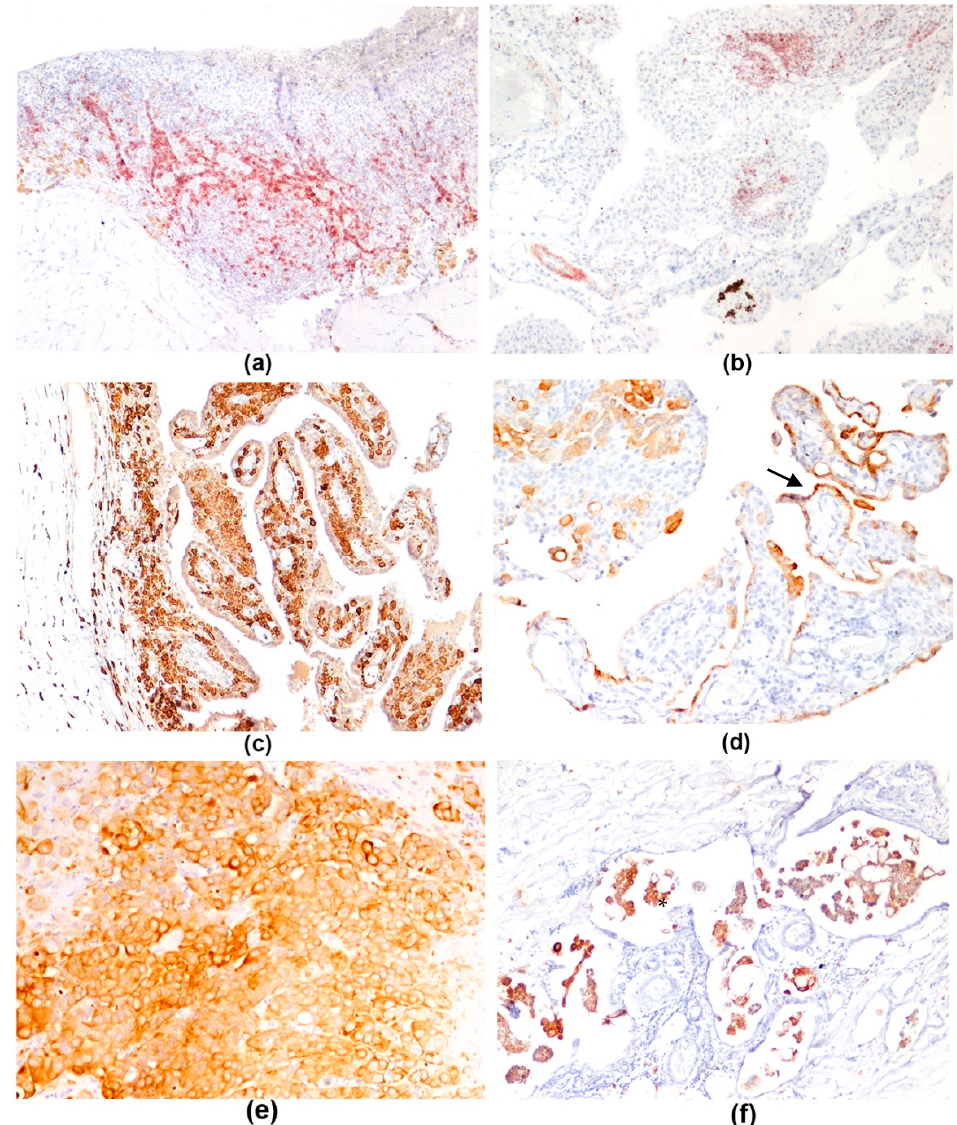
Figure 3. Pericardium, dog, immunohistochemistry. ( a ) Idiopathic pericarditis. Pericardium is infiltrated by numerous lymphocytes CD3 positive, stained in red (AEC), 40×. ( b ) Idiopathic pericarditis. Few lymphocytes CD79a positive, stained in red (AEC), are present in the reactive papillae, 40×. ( c ) Idiopathic pericarditis. Numerous Iba1 positive macrophages, stained in brown (DAB) are present in the papillary hyperplasia of mesothelium, 100×; ( d ) Idiopathic pericarditis. A single layer of mesothelial cells (arrow) covering hyperplastic papillae is highlighted with pan-cytokeratin, 100×; ( e ) Solid mesothelioma. Multilayering of intense pan-cytokeratin positive neoplastic mesothelial cells, stained in brown (DAB), 200×. ( f ). Solid mesothelioma. Multiple neoplastic emboli are pan-cytokeratin positive (asterisk), 200×.